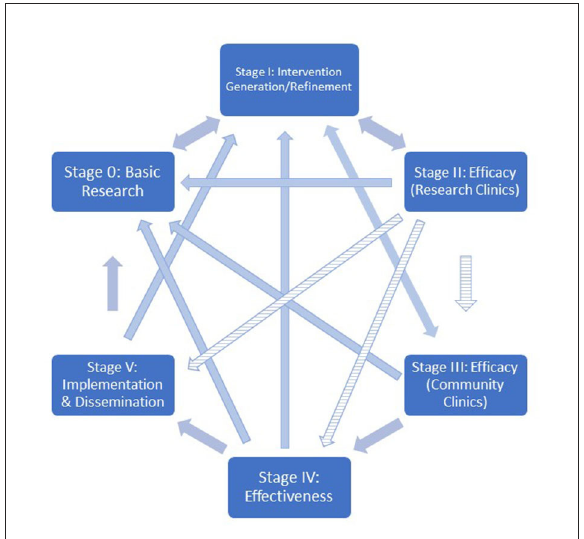
FIGURE2 Recreation of Figure 1 from Onken et al. (72). Depiction of the NIH stage model. Notched arrows denote pathways that should be considered with